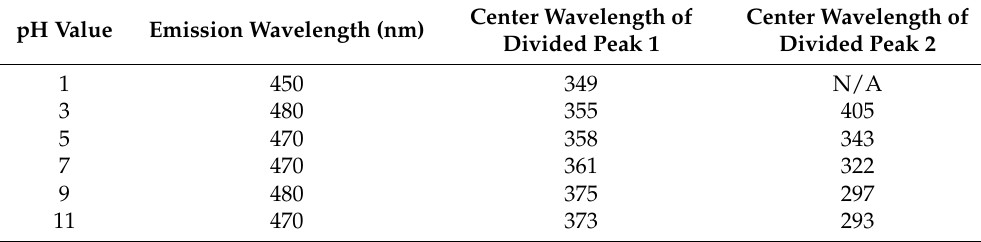
Figure 5. Gauss fitting of PLE spectra with the silicon NC colloid pH values at ( a ) 1, at the emission wavelength 450 nm; ( b ) 3, at the emission wavelength 480 nm; ( c ) 5, at the emission wavelength 470 nm; ( d ) 7, at the emission wavelength 470 nm; ( e ) 9, at the emission wavelength 480 nm; and ( f ) 11, at the emission wavelength 470 nm. Table 2. The center wavelengths of two divided peaks corresponding to typical PLE curves at different pH values.